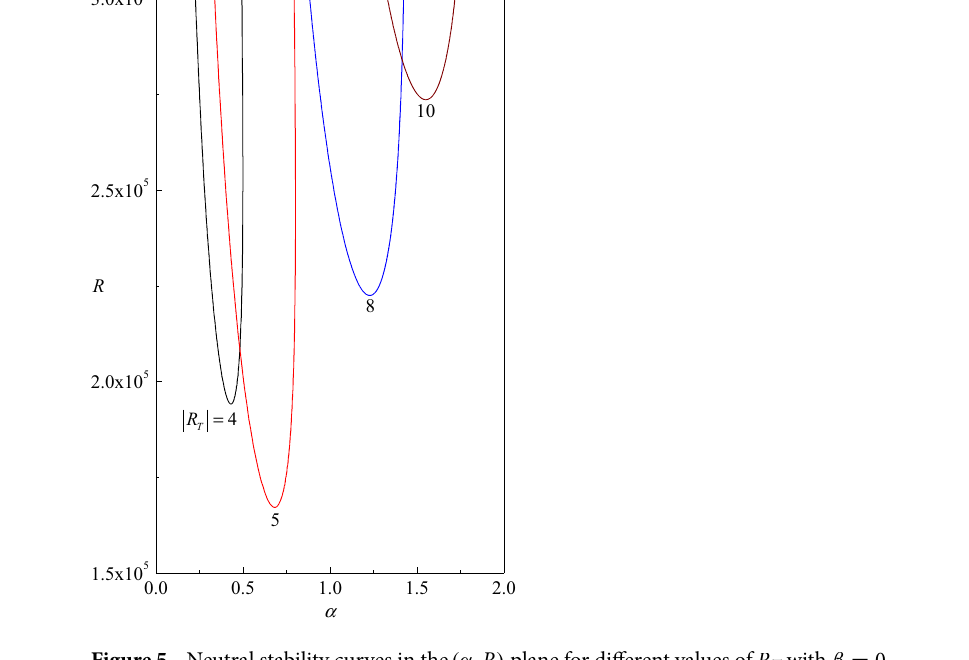
Figure 5. Neutral stability curves in the (α , R ) -plane for different values of R T with β = 0